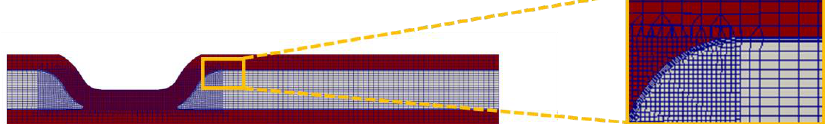
Figure 11. Dimple-type turbulator: Detail of the two regions mesh adopted for the calculations at the micro-scale.